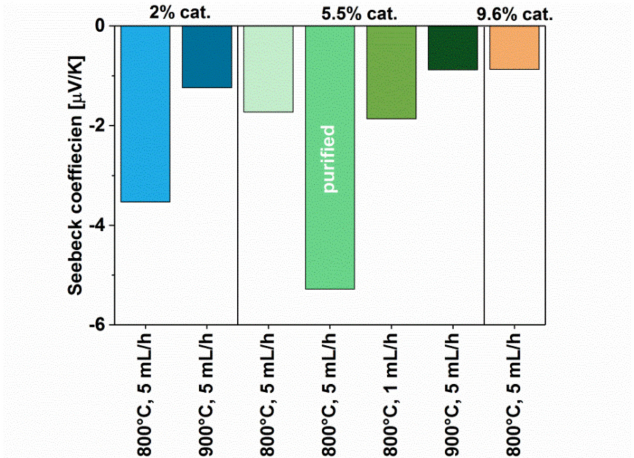
Figure 10. Seebeck coe ffi cient of MWCNTs synthesized using di ff erent parameters (with and without post-processing).